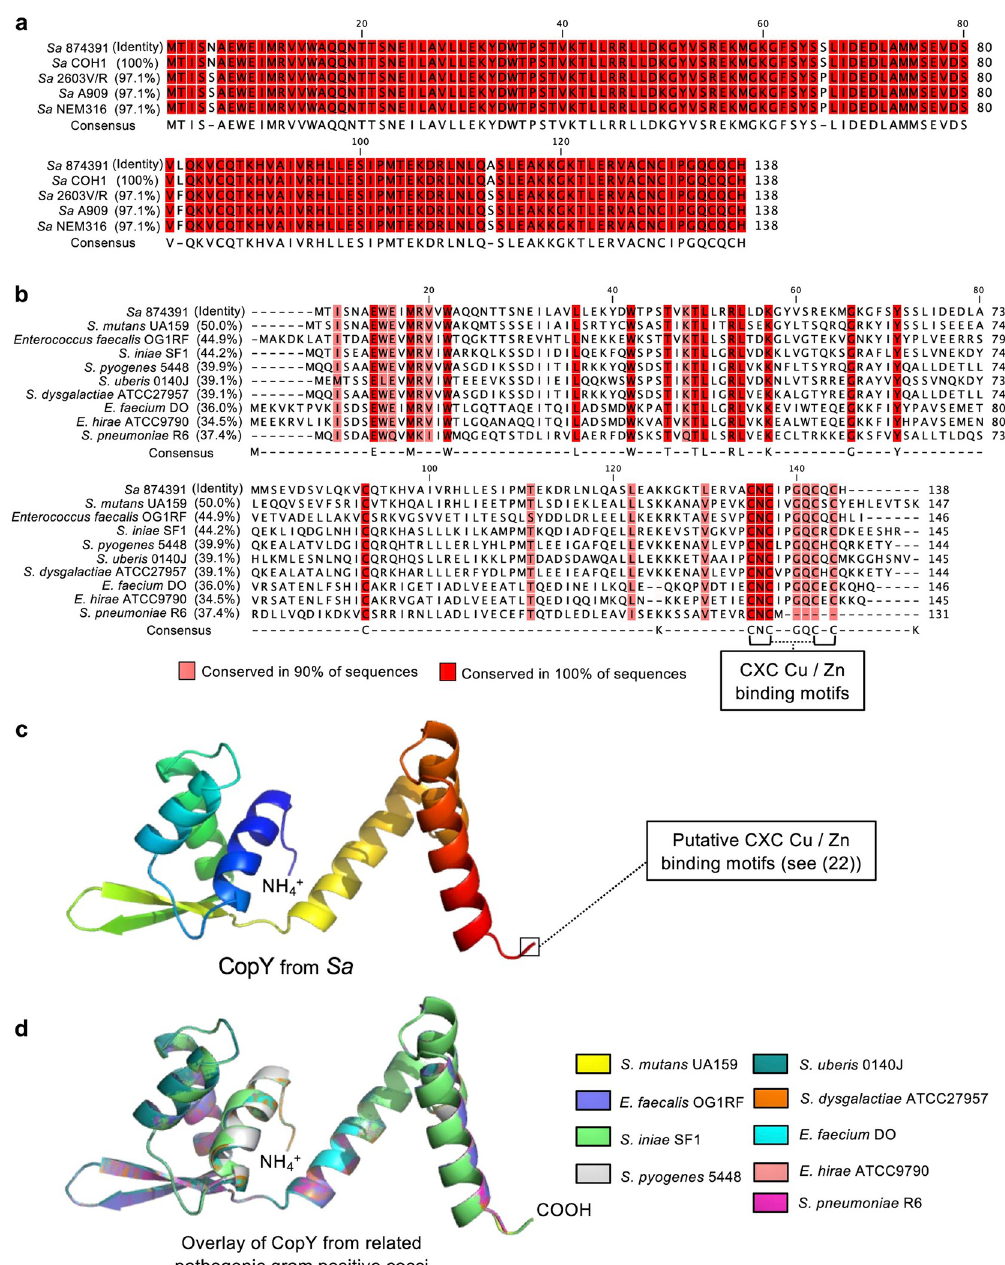
Fig 8. CopY likely operates as a cross-system regulator in numerous gram-positive bacteria. Alignment of CopY shows a high degree of conservation ( > 97% identity between reference S . agalactiae strains) (a). Alignment of S . agalactiae CopY with other Streptococcus and Enterococcus strains. Highlighted are two conserved putative CXC motifs that are predicted to bind Cu and/or Zn at the C-terminus; amino acids that are > 90% conserved are shaded in red, as indicated (b). Predicted structural model of S . agalactiae CopY and putative region of metal binding at the C-terminus of the protein (c). Structural alignments of predicted CopY proteins from Streptococcus and Enterococcus strains indicate overlapping protein conformation despite modest conservation of amino acid identity